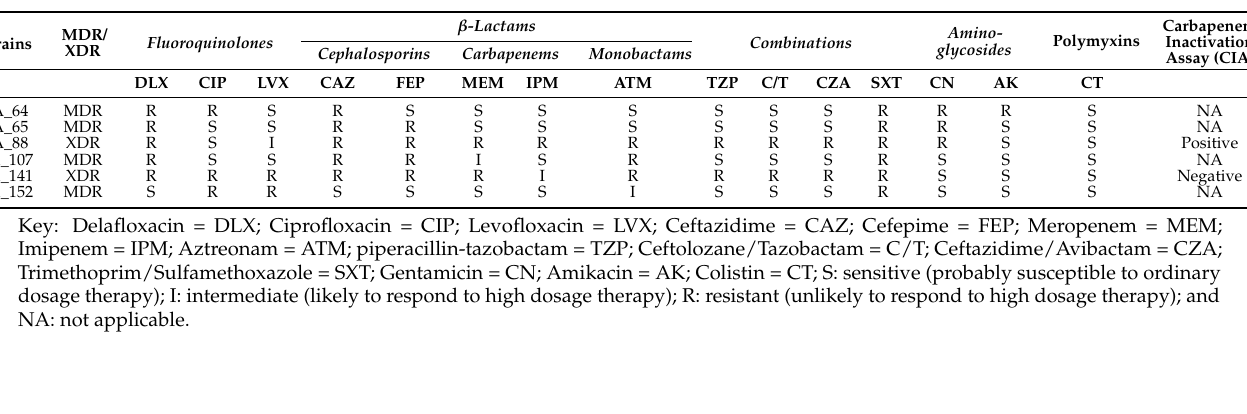
Table 1. Antibiotic susceptibility profile of P. aeruginosa